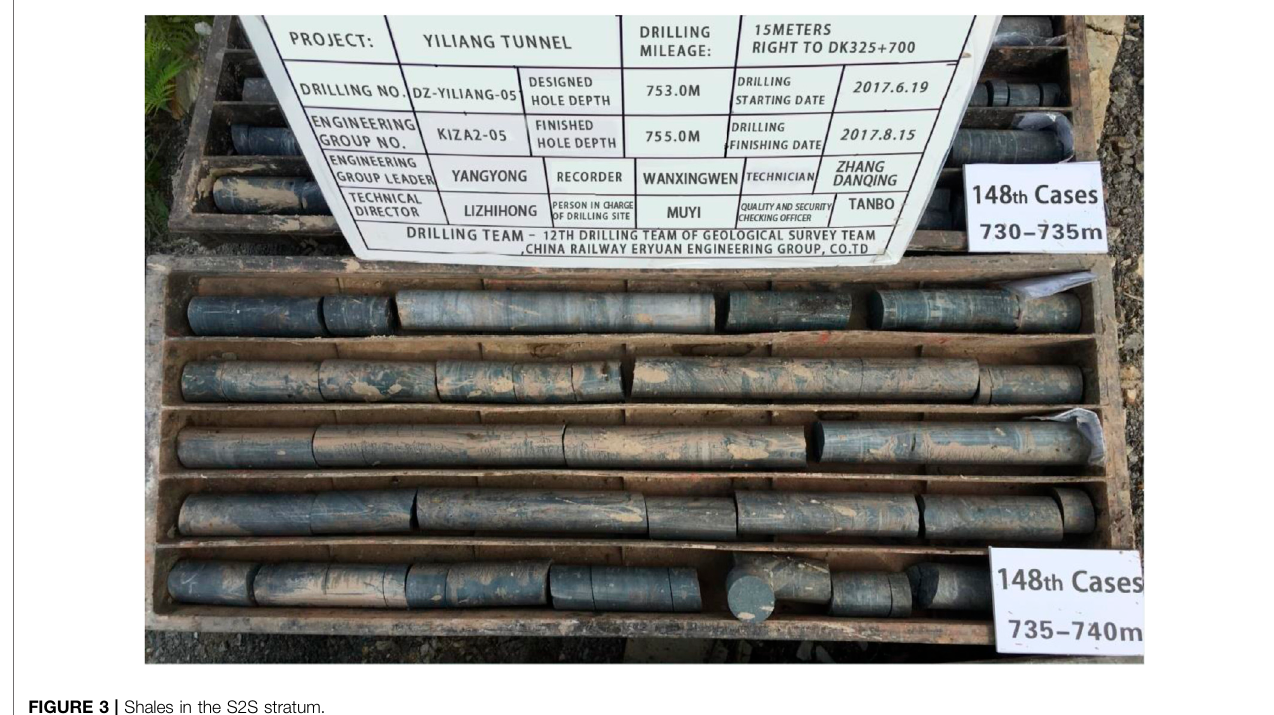
FIGURE 3 | Shales in the S2S stratum.